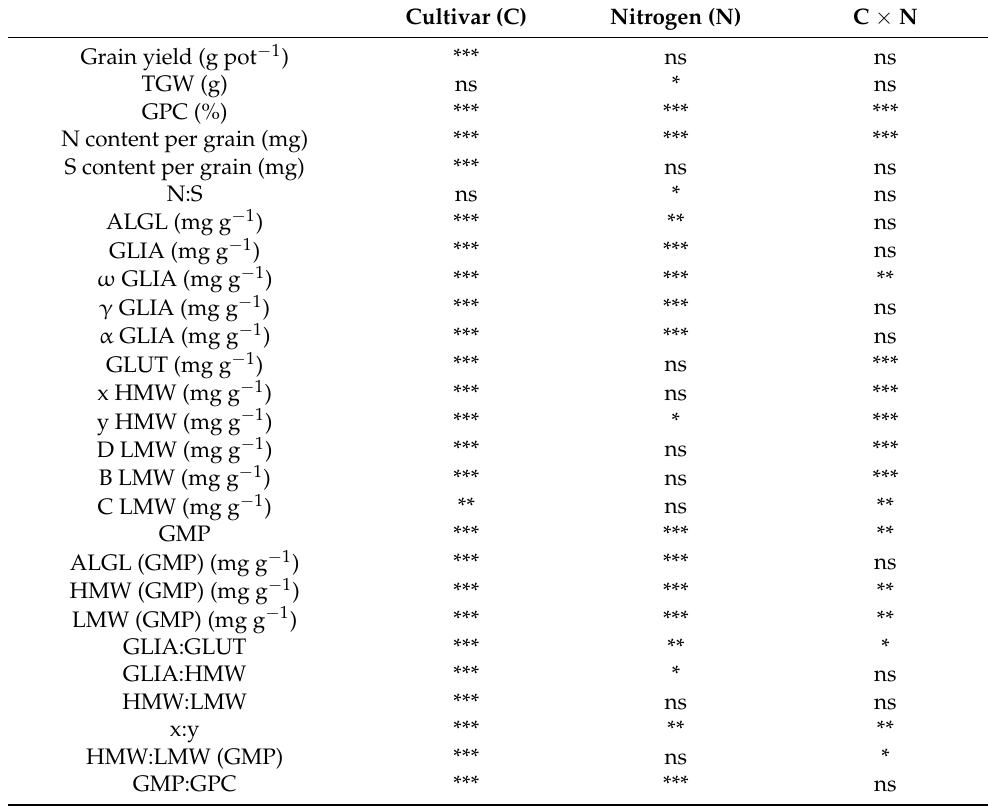
Table 2. Two-way ANOVA result of the effect of cultivar and excessive N supply on grain yield, thousand grain weight (TGW), grain protein concentration (GPC), N and S content per grain, grain N to S ratio, concentration of different grain protein fractions and ratios between different protein fractions. *, p < 0.05; **, p < 0.01; ***, p < 0.001; ns, not significant ( p ≥